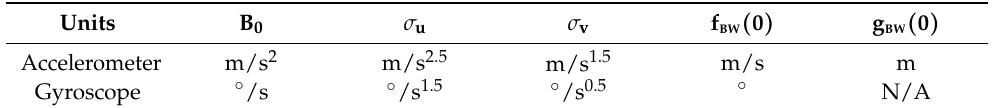
Table 4. Units for single-axis inertial sensor error